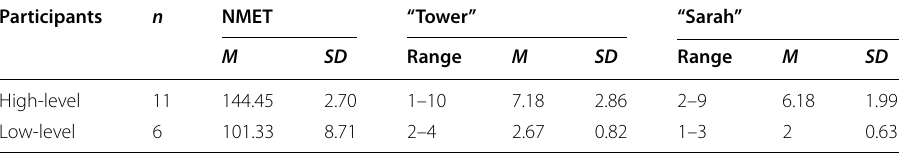
Table 1 Participants’ NMET and task scores